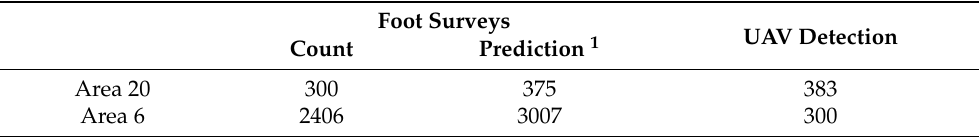
Table 1. Summarized results from Area 20 and Area